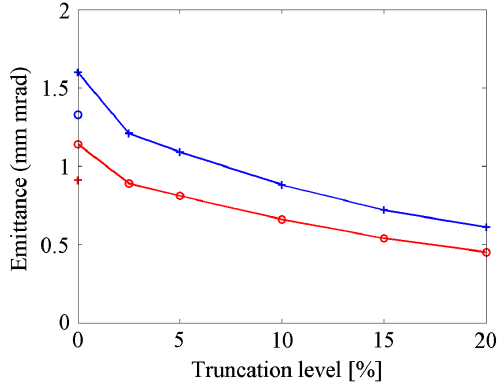
FIG. 30. Emittance analysis of the 100 pC data in Fig. 29(c) as a function of truncation level used in computing the rms bunch sizes. The Gaussian fit results are plotted at 0% truncation. The blue points are from the horizontal scans and the red points are from the vertical